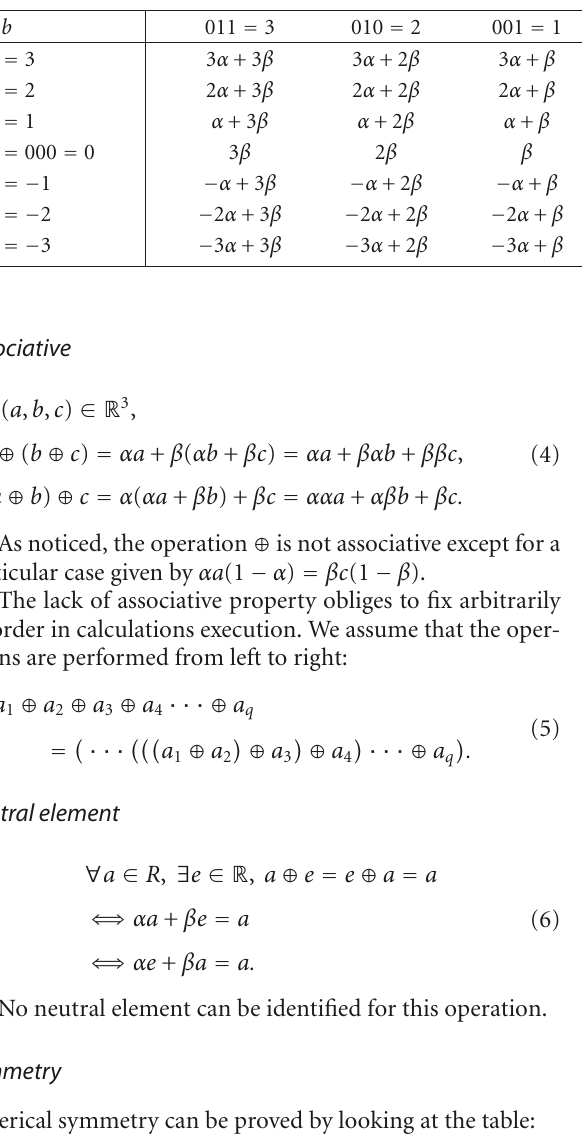
Table 3: Definition of the operation ⊕ for k =